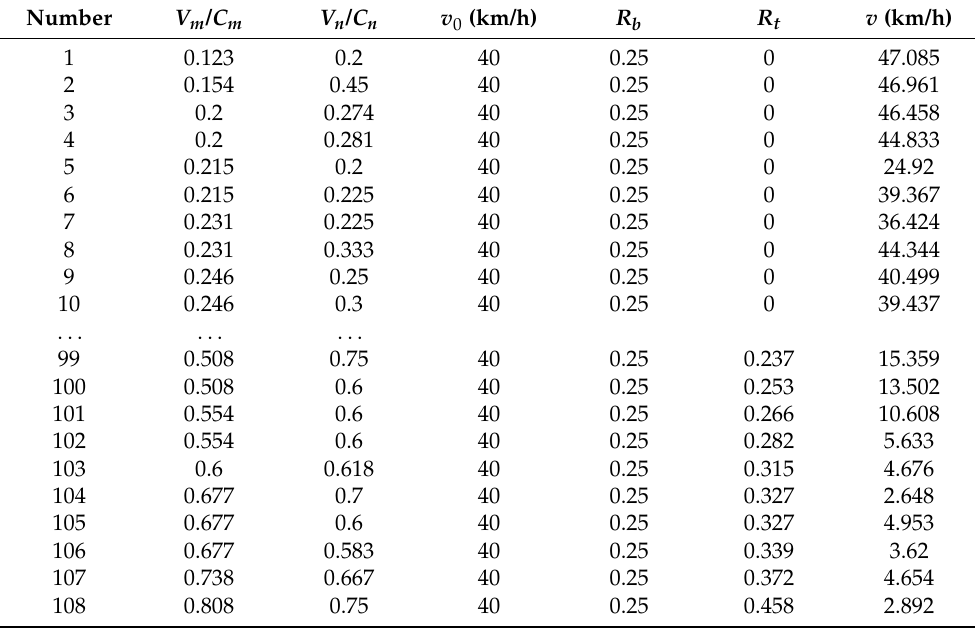
Table A4. BPR model parameters during roadside parking in scenario B2 (example).